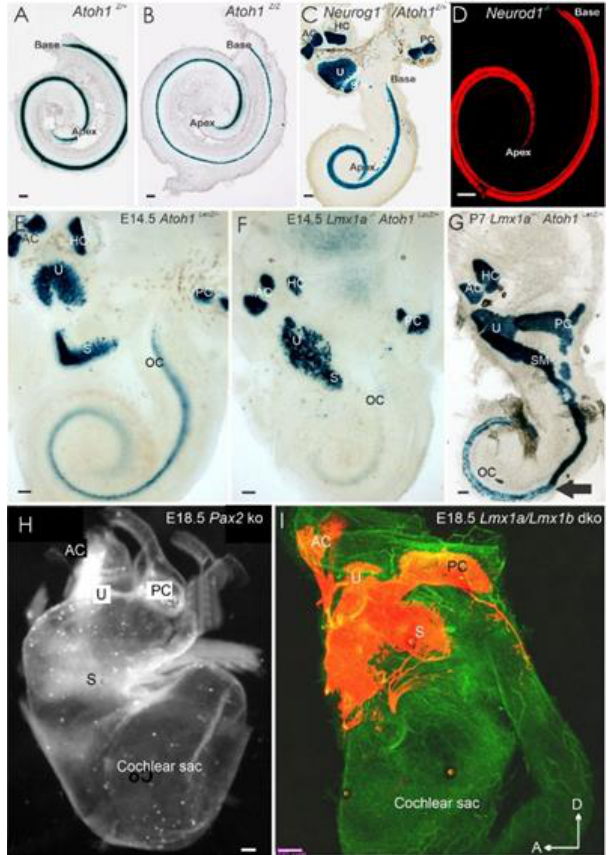
Figure 4. Effect of gene loss on the cochlea. Loss of Atoh1 has a limited effect on cochlea extension ( A , B ) compared to Neurog1 ( C ) and Neurod1 ( D ), in which the cochlea is shortened. Early Atoh1 LacZ shows expression in hair cells near the apex ( E ) Atoh1 LacZ expression is delayed in Lmx1a null mice ( F ). Later stages of Lmx1a null mice show that the hair cells develop, though there is the fusion of the saccule and OC (arrow; G ). Mice lacking Pax2 ( H ) or Lmx1a/Lmx1b develop only a cochlear sac without innervation. AC, anterior crista, HC, horizontal crista; OC, organ of Corti; PC, posterior crista; S, saccule; U, utricle. A/D in I indicates dorsal and anterior directions, large arrow indicates the shift of near normal to unusual cochlear hair cells (G). Bar 10 µm (A–H), 100 µm ( I ) Modified after [12,66–69].